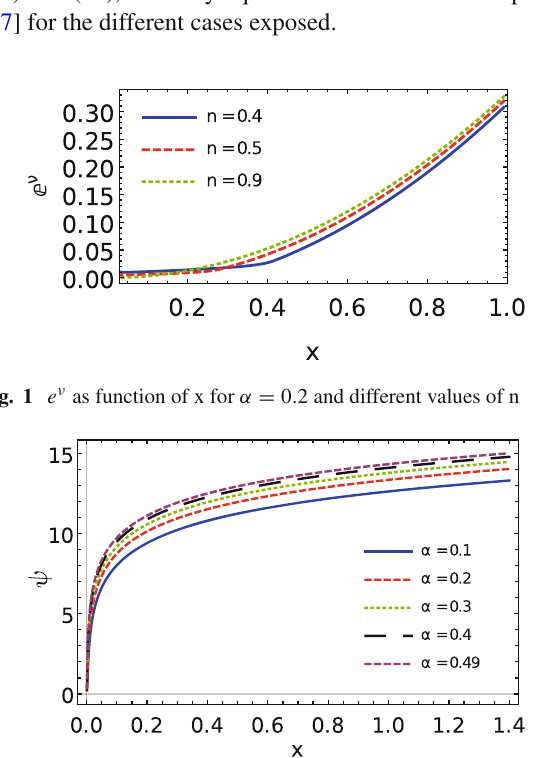
Fig. 2 ψ as function of x ( γ = 1 isothermal case) for different values of α